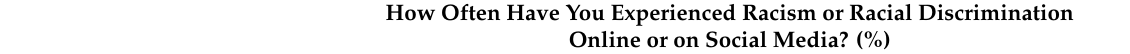
Table 2. Experience of online racism during the COVID-19 pandemic, by demographics ( n :